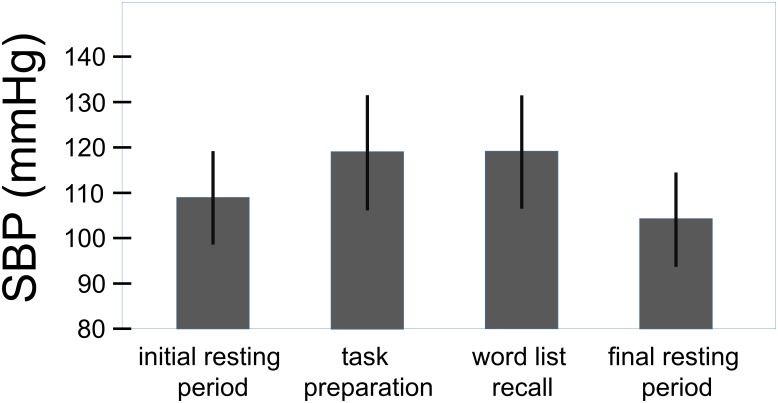
Overall effect of the challenge on the systolic blood pressure (total sample, n = 70). Whiskers represent standard deviations. (F(3,207) = 59.7, p < 0.001, η2 = 0.464).